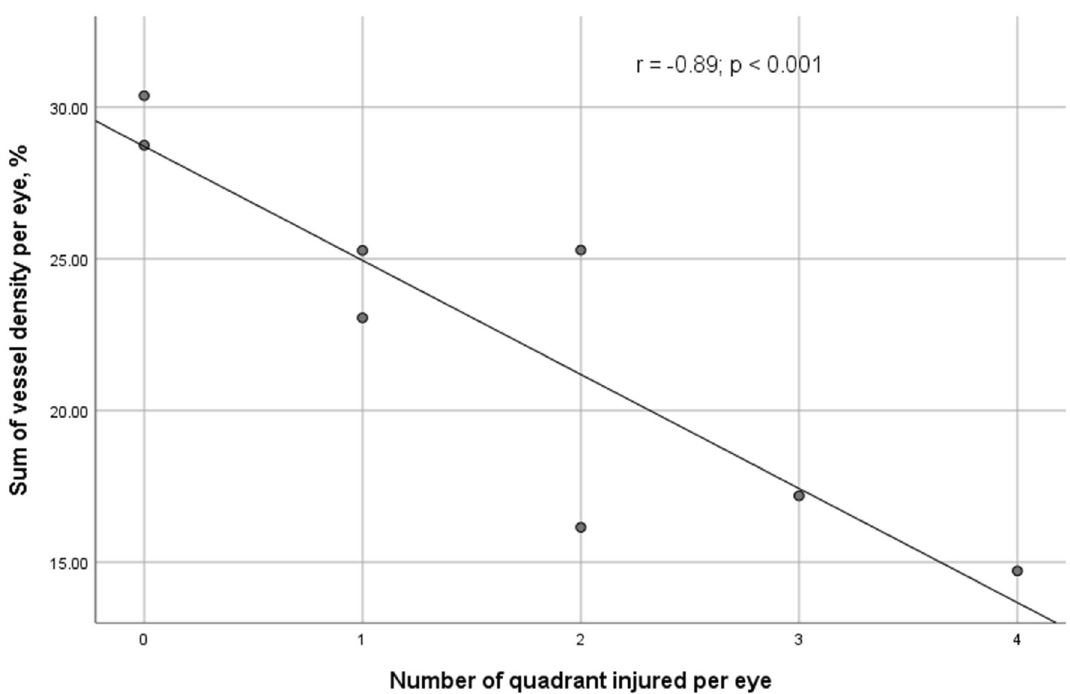
Figure 4. Scatter plot of anterior segment-optical coherence tomography angiography vessel density (AS-OCTA) values against the number of quadrants injured per